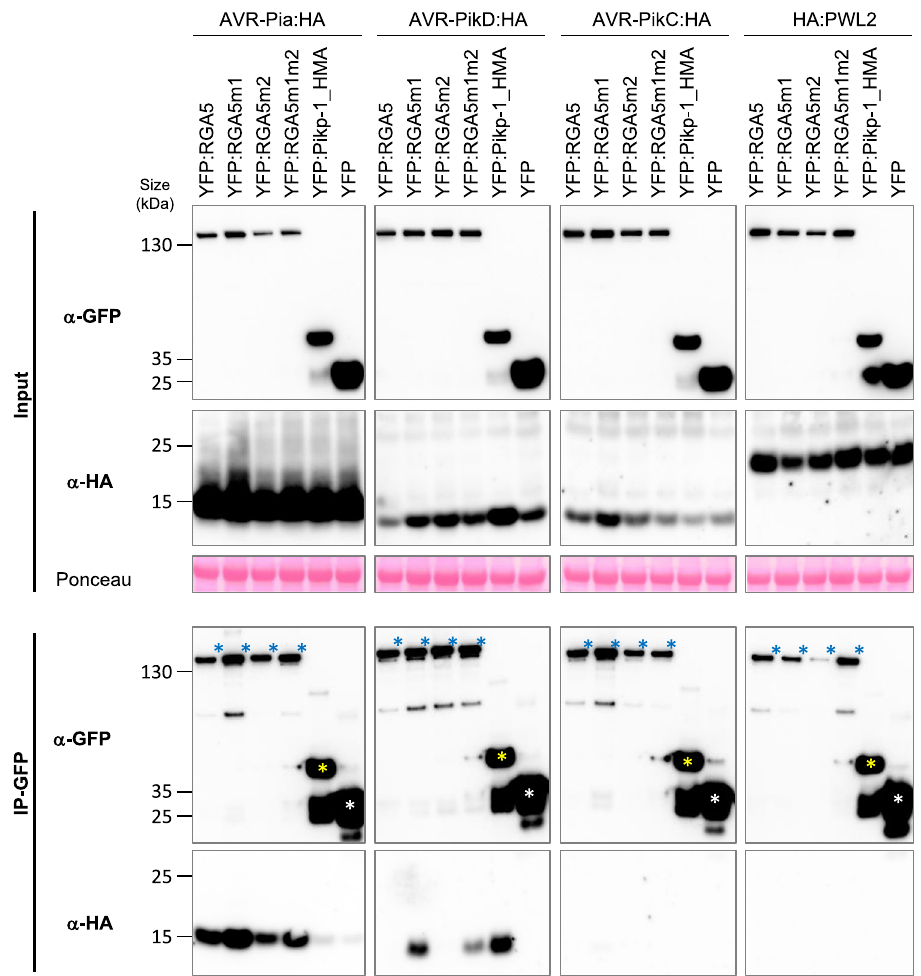
Fig. 5 In planta association of the engineered full-length RGA5 receptors with MAX effectors. The full-length RGA5 protein and related m1, m2, and m1m2 variants fused to YFP were transiently co-expressed in N . benthamiana leaves with the indicated HA-tagged effectors (without signal peptides). The HMA domain of Pikp-1 (fused to YFP) was used as a control as well as YFP alone and the M. oryzae effector PWL2. Proteins were extracted 48 h after in fi ltration, separated by gel electrophoresis, and tagged proteins were detected in the extract (input) and after immunoprecipitation with anti-GFP beads (IP-GFP) by immunoblotting with anti-HA ( α -HA) and anti-GFP ( α -GFP) antibodies. In the IP-GFP/ α -GFP panel, yellow and white asterisks indicate the YFP:Pikp-1_HMA and YFP proteins respectively, while blue asterisks show the YFP:RGA5 wild type and mutant proteins. Ponceau staining shows equal protein loading in the input. The experiment was carried out twice with identical